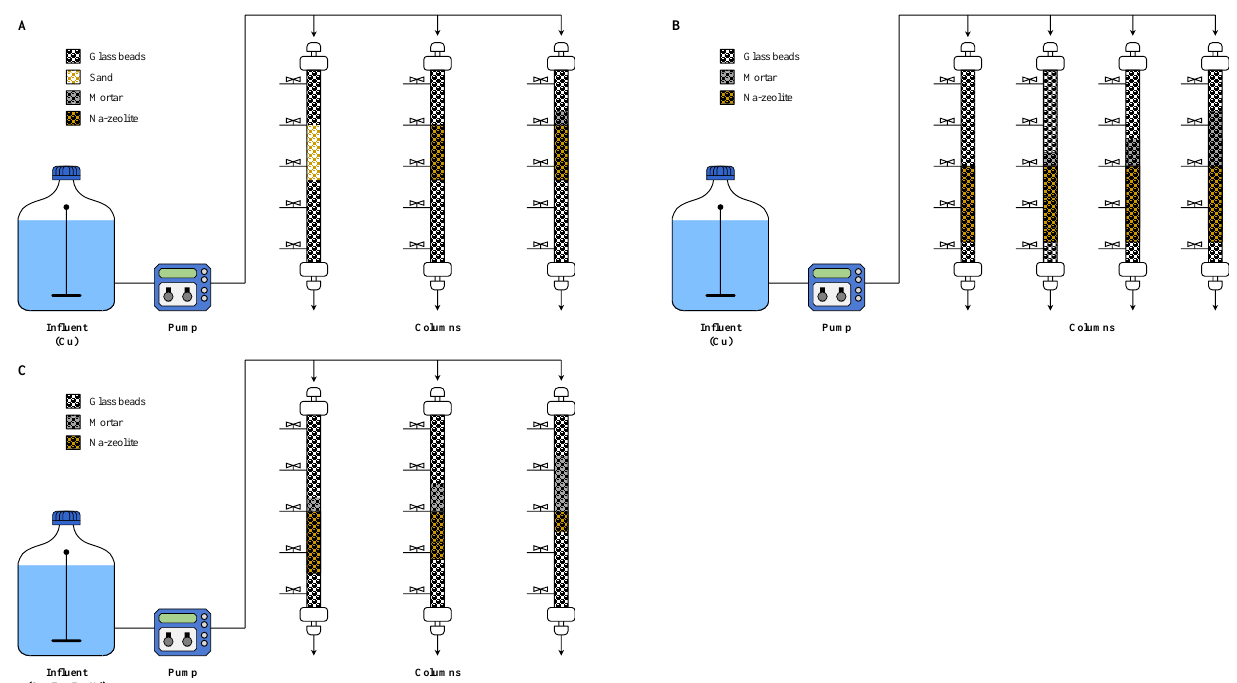
Figure 1. Schematics of the experimental setup for ( A ) the removal of Cu 2+ using sand, Na-zeolite, or mortar/Na-zeolite; ( B ) the removal of Cu 2+ using mortar/Na-zeolite with different depths of mortar; and ( C ) the removal of a metal mixture using mortar/Na-zeolite with different ratios of mortar and Na-zeolite depths.